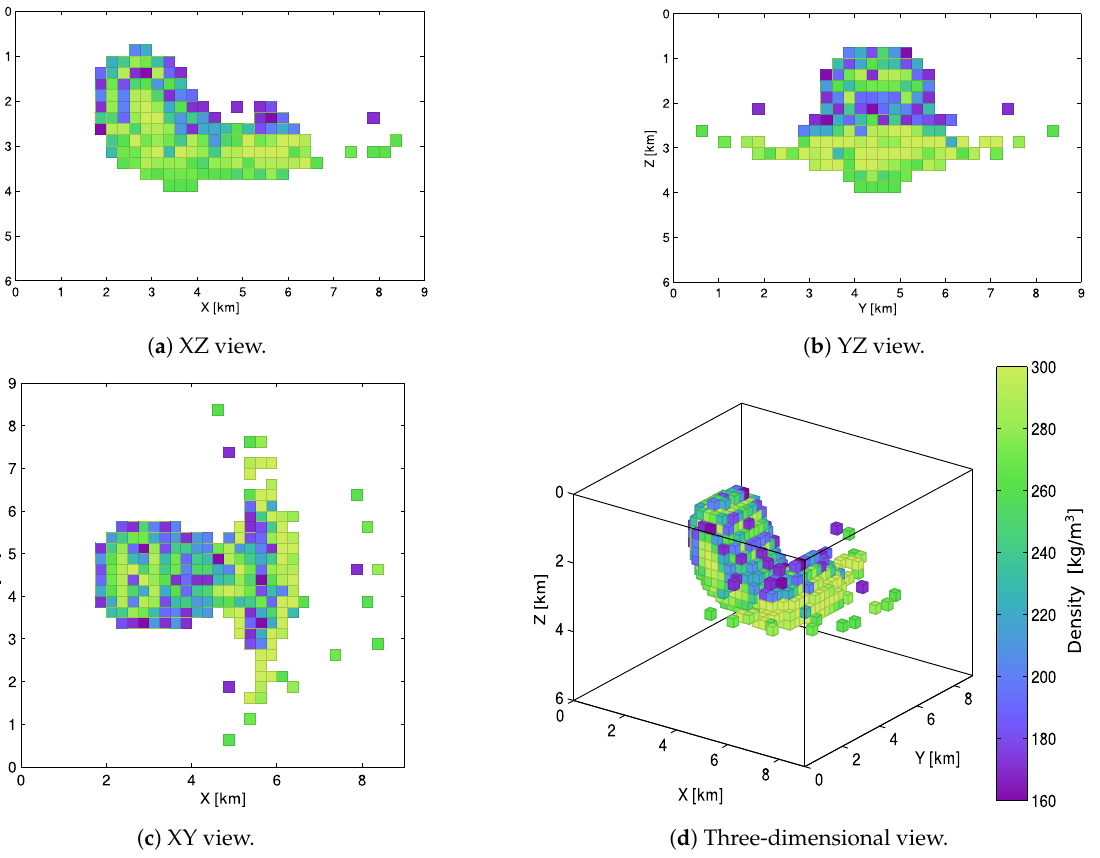
Figure 24. Inverted gradiometric S